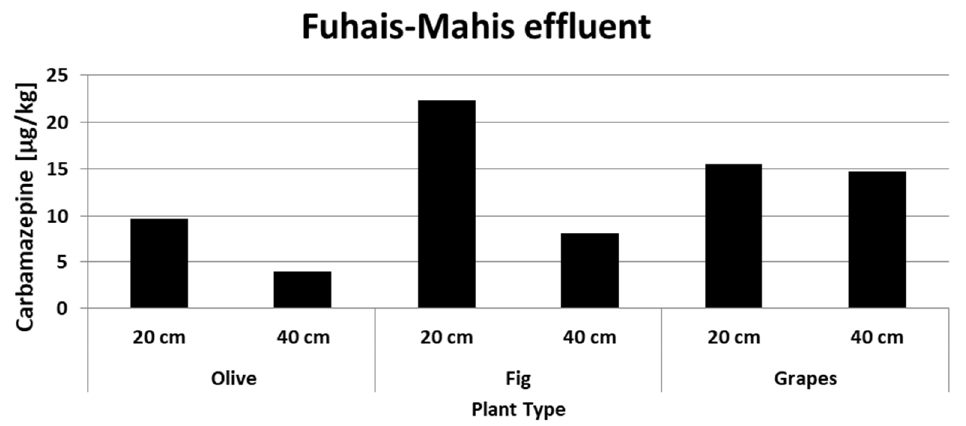
Figure 6. The concentration of carbamazepine in soils cultivated with various plants and irrigated by Fuhais-Mahis effluents in Mahis city.